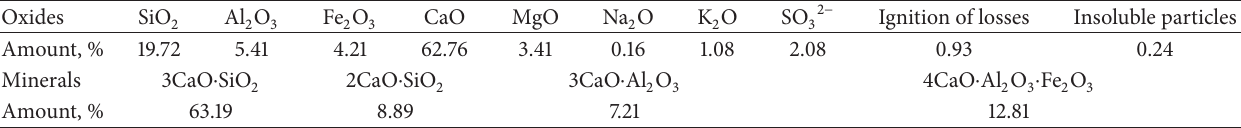
Table 1: Chemical and mineralogical composition of